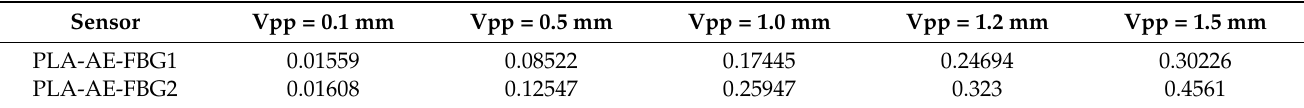
Table 3. The response data of PLA-AE-FBG sensor under different excitation signals. Sensor